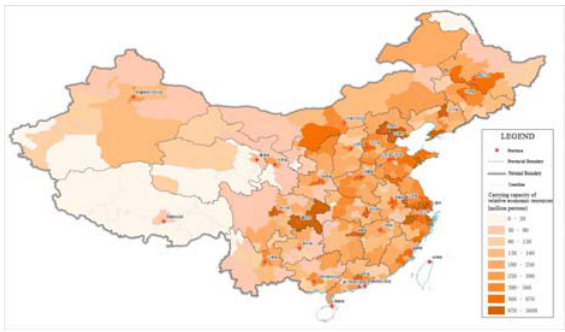
Figure 4. Carrying capacity of relative economic resources in China